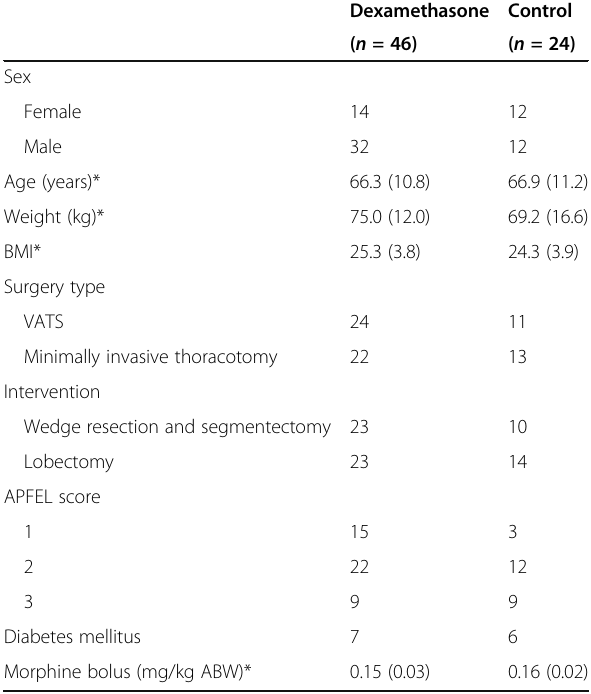
Table 1 Patient demographics and intraoperative characteristics